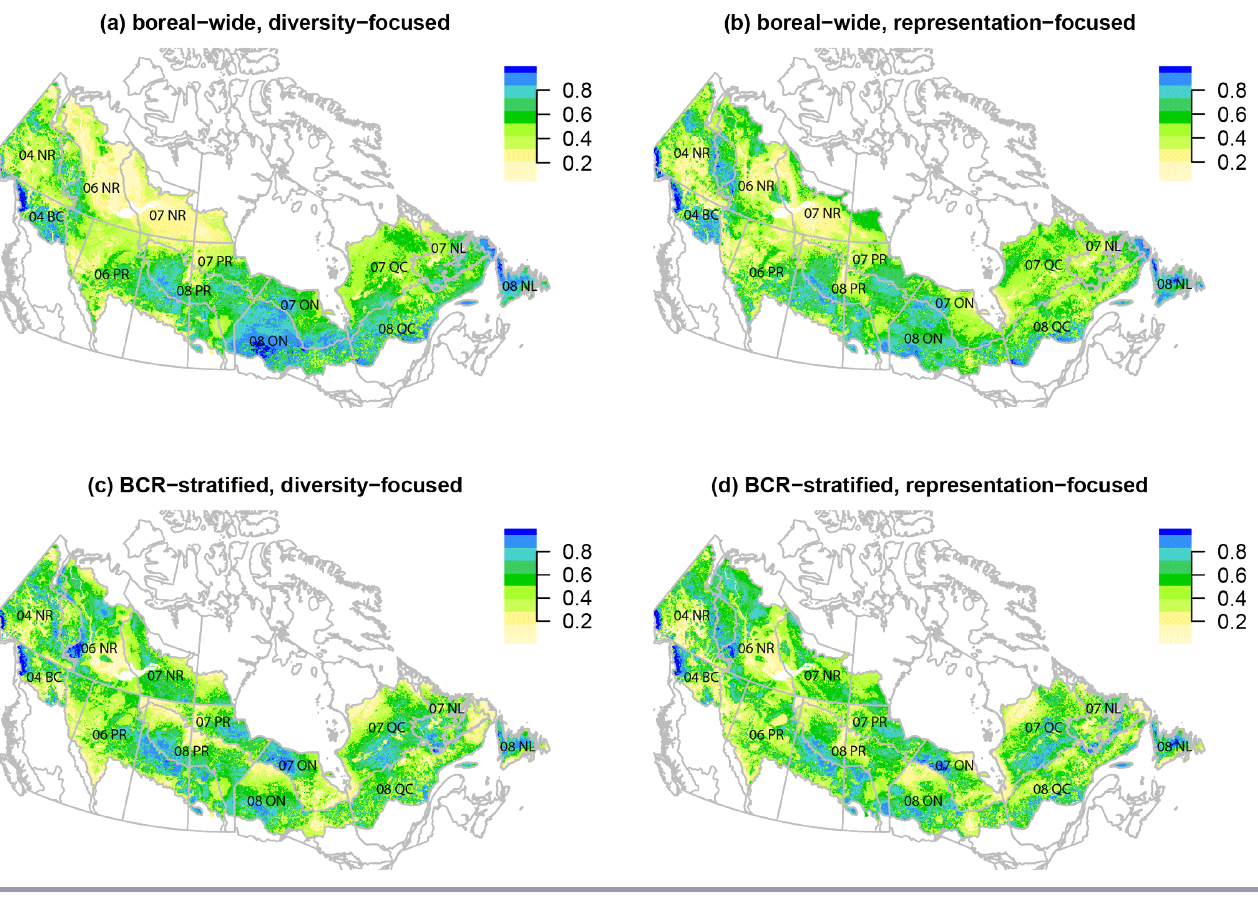
Fig. 6 . Means for four groups of 32 scenarios: boreal-wide, diversity-focused (a) and representation-focused (b), and bird conservation subregion-stratified diversity-focused (c) and representation-focused (d). Highest Zonation ranks are in dark blue; lowest ranks are in yellow. BCR = bird conservation